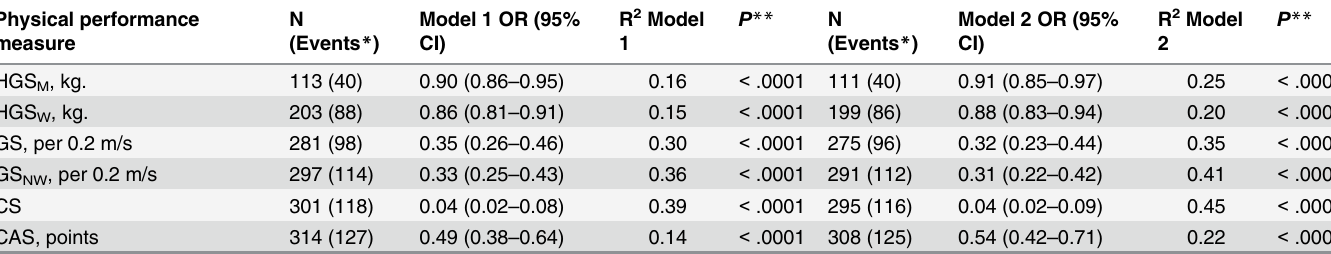
Table 2. Logistic regression models for mobility limitations in older medical patients 30 days after discharge. Physical performance